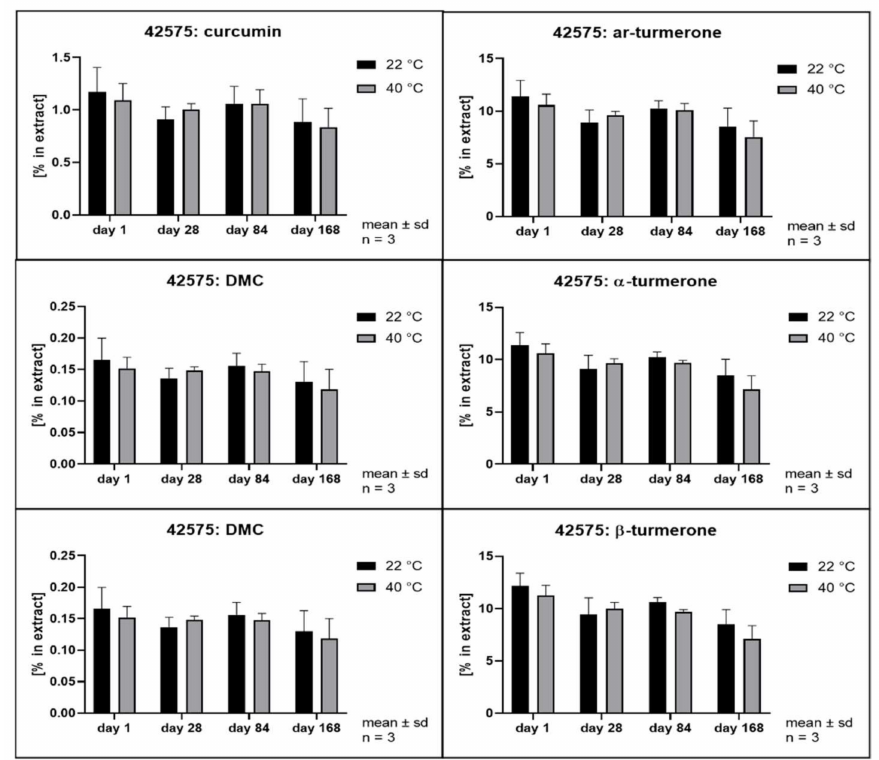
Figure 12. Contents of individual curcuminoids and turmerones in scCO 2 extracts throughout storage, extraction at 425 bar and 75 ◦ C